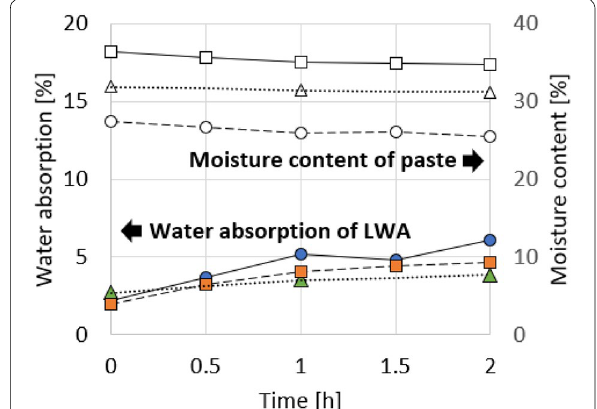
Fig. 2 Moisture content measured with cement paste and mortar samples (the variation of the measurement is less than 1% at each point).